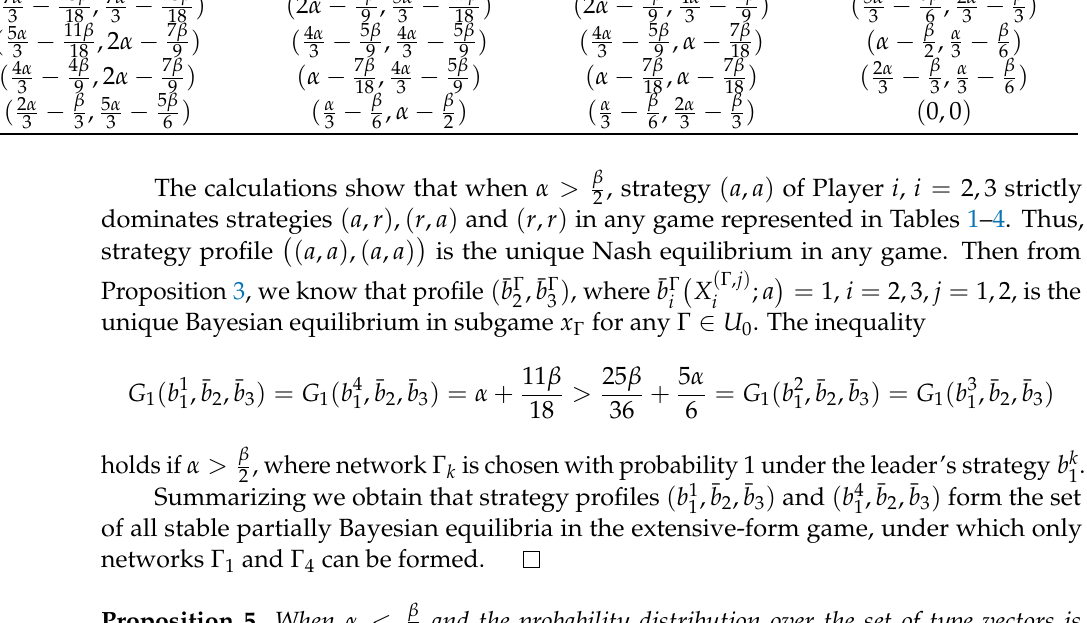
Table 4. Strategic form of subgame x Γ